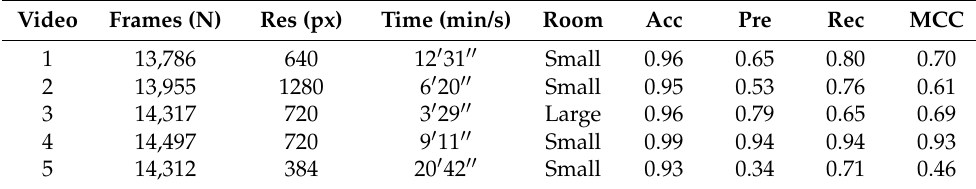
Table 3. Model evaluation